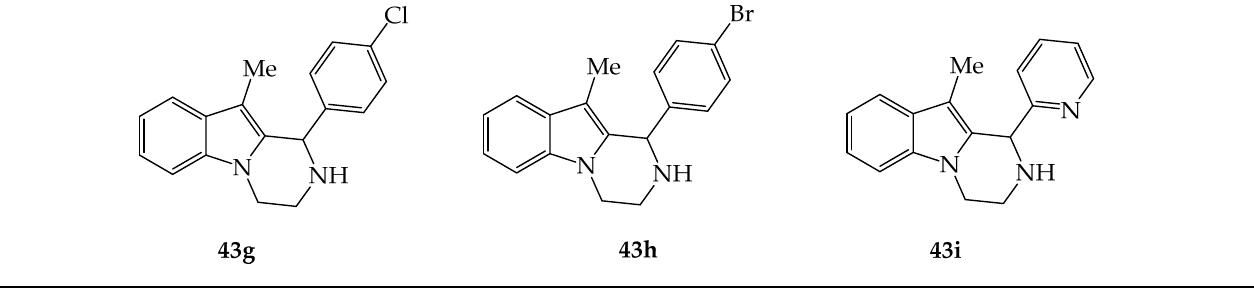
Table 2. Anti-fungal properties of tetrahydro-pyrazinoindoles 43g–I and 43c .